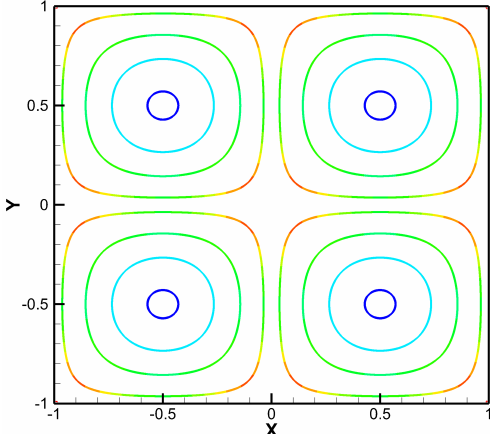
Figure 1. The streamline pattern of the Taylor–Green vortices problem at t = 1.0 computed by using the 4th-order compact difference scheme on the 128 × 128 grid, with coloring by pressure magnitude.